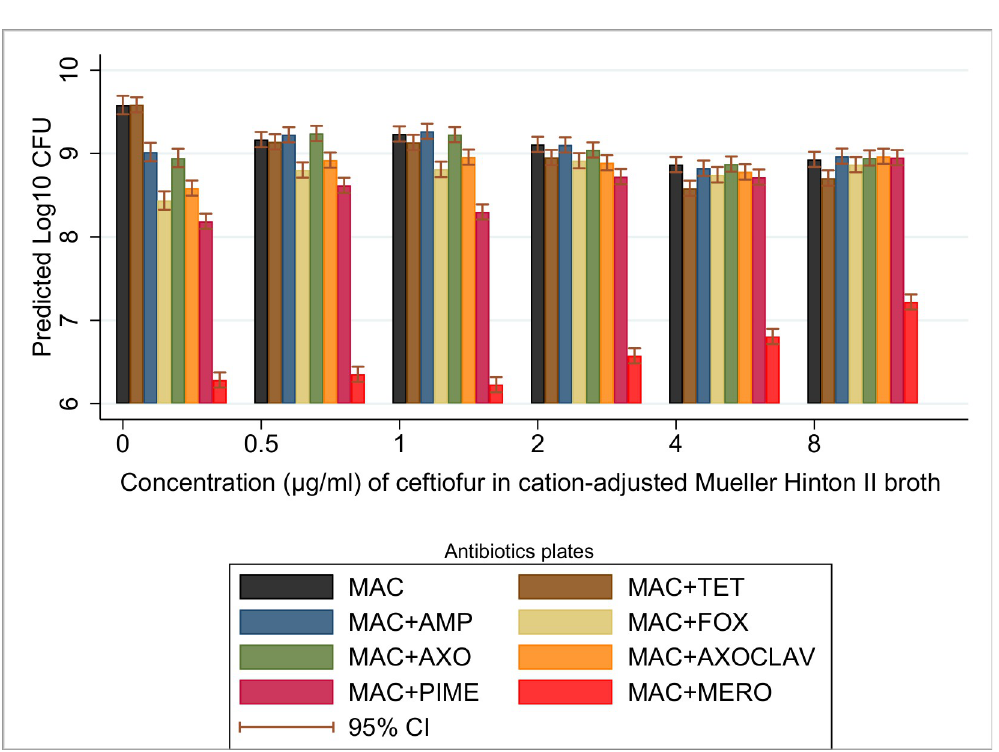
Fig 5. Concentration effects of ceftiofur on 10-strain mixed-bacterial culture. Predicted marginal mean CFU with 95% CI following 24-hour incubation in ceftiofur (at 0.5, 1, 2, 4, 8 μ g/mL) in cation-adjusted Mueller-Hinton II broth. � MacConkey agar plate antibiotic concentrations: ampicillin (32 μ g/mL), tetracycline (16 μ g/mL), cefoxitin (32 μ g/mL), ceftriaxone (4 μ g/ mL), ceftriaxone (4 μ g/mL) + clavulanic acid (4 μ g/mL), cefepime (8 μ g/mL), and meropenem (4 μ g/mL); CFU (Colony forming